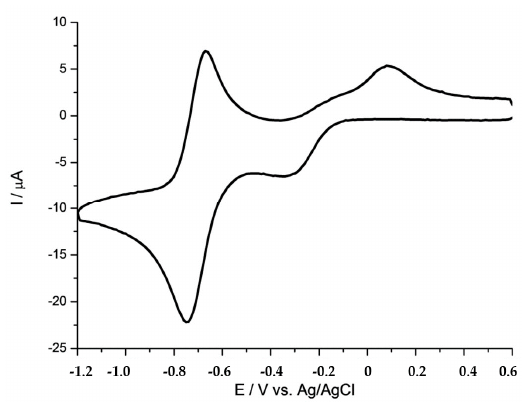
Figure 4. Cyclic voltammogram of [CoCl(dpgH) 2 (pytpy)] taken at 0.1 V/s in DMF 0.1 M TBAPF 6 using a vitreous carbon working electrode. Fc+/Fc vs. Ag/AgCl = 0.55 V in DMF [12]. Table 1. Electrochemical data of [CoCl(dpgH) 2 (pytpy)] and [CoCl(dpgH) 2 (py)].